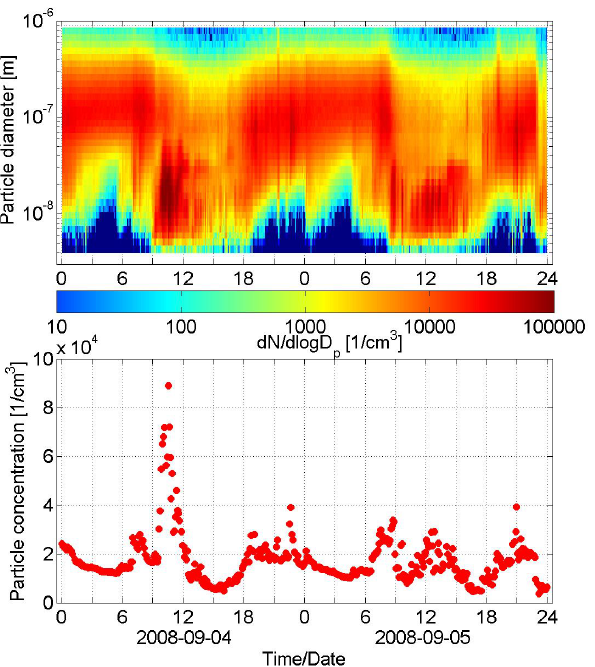
Fig. 5. Nucleation event and subsequent growth as seen during 4–5 September 2008 in Gual Pahari.